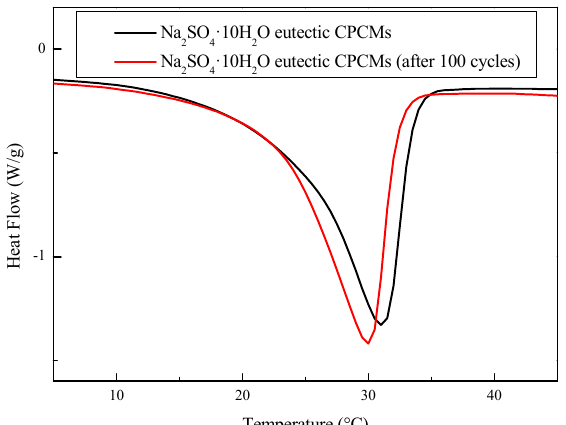
Figure 15. DSC curves of the Na 2 SO 4 ·10H 2 O eutectic CPCMs before and after 100 melting–freezing cycles.